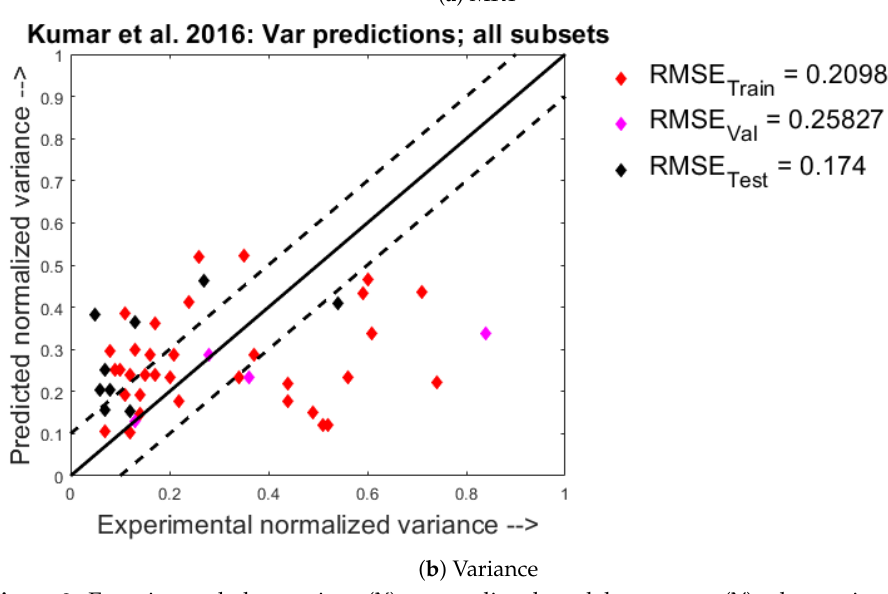
Figure 9. Experimental observations (X) vs. predicted model responses (Y) when trained on the Kumar et al. 2016 [26]